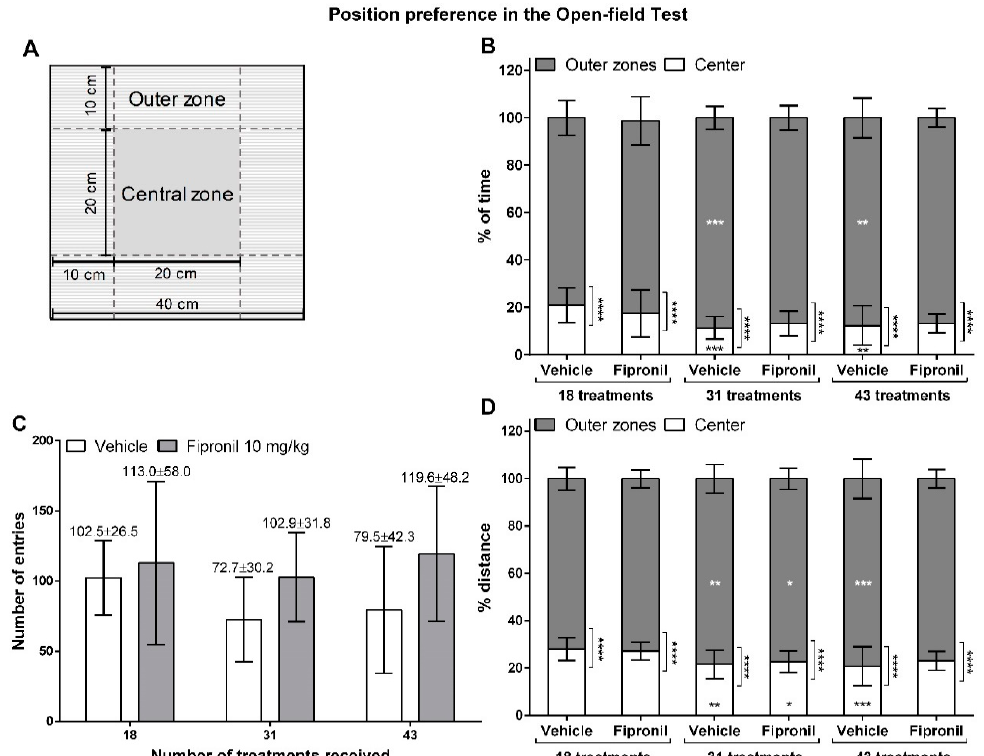
Figure 4. Position preference in the open-field test. ( A ) Schematic representation of the open-field arena and of the defined zones. ( B ) Relative time spent by the animals from the two treatment groups in the center and outer zones of the open-field arena during the three testing sessions. Treatment type has no significant influence on the relative time spent in the outer or central zones of the open field. ( C ) Number of entries in the central zone by the animals of the two treatment groups during the three testing sessions, mean values ± SD are indicated above the bars. Neither treatment type nor treatment duration had a significant e ff ect on the number of entries to the central zone (and there were no significant di ff erences between treatment groups). ( D ) Relative distance travelled by the animals from the two treatment groups in the center and outer zones of the open-field arena during the three testing sessions. Treatment type has no significant influence on the relative distance travelled in the outer or central zones of the open-field arena). *: p ≤ 0.05; **: p ≤ 0.01; ***: p ≤ 0.001; ****: p ≤ 0.0001. Table 1. Measures of thigmotaxis. Relative time spent (upper value) and distance travelled (lower value) by the animals of the two treatment groups in the di ff erent zones of the open-field arena. Testing Session Group Center Zone (%) Outer Zones (%)